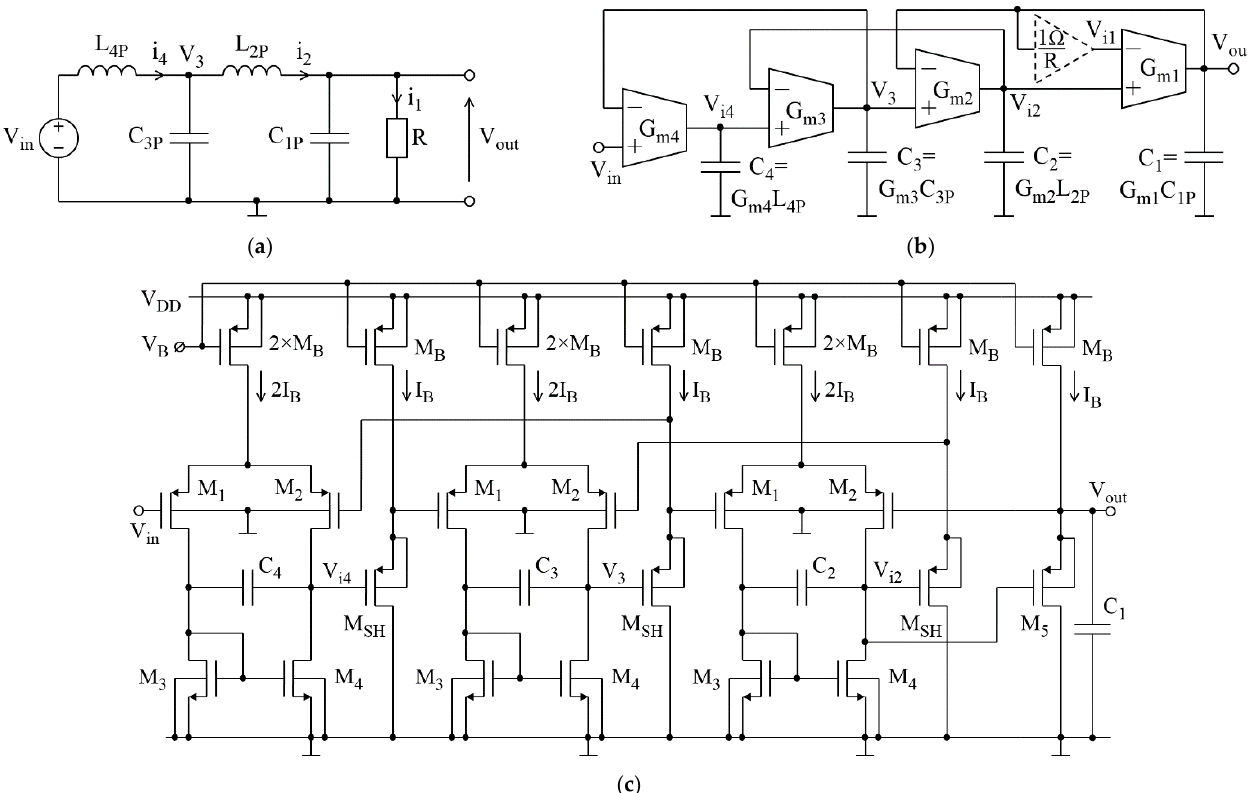
Figure 7. The 0.4-V, 100-Hz, fourth-order filter: ( a ) single-resistance terminated ladder prototype; ( b ) OTA-C (Gm-C) schematic; ( c ) transistor-level circuit. C 1 = 4.98 pF, C 2 = 6.73 pF, C 3 = 9.80 pF, C 4 = 9.50 pF, and I B = 250 pA assuming Butterworth approximation and f − 3dB of 100 Hz.